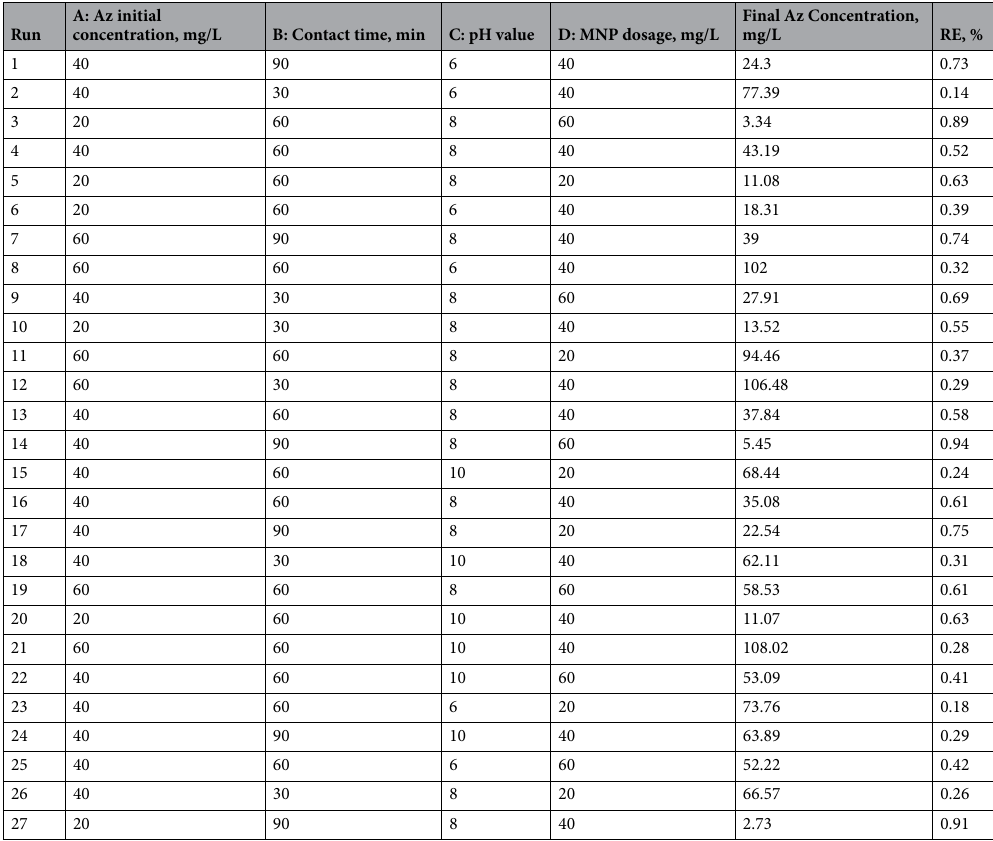
Table 3. Experiment conditions using BBD